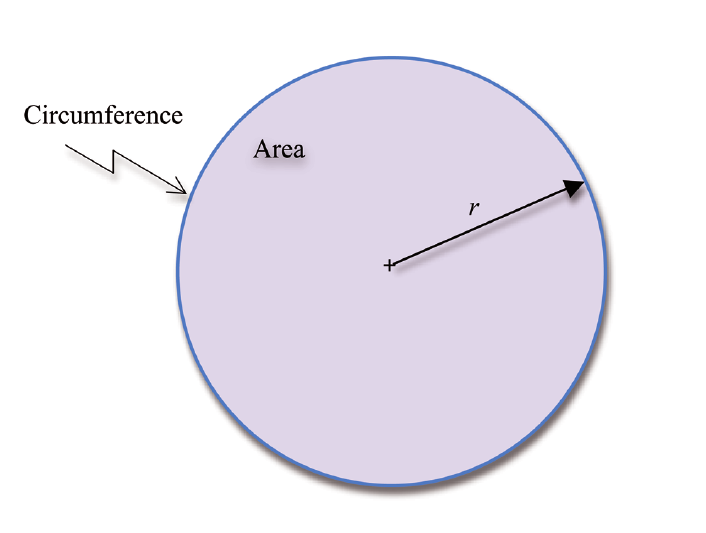
Figure 1. A Euclidean’s circle with a radius r , a circumference C , and an area A